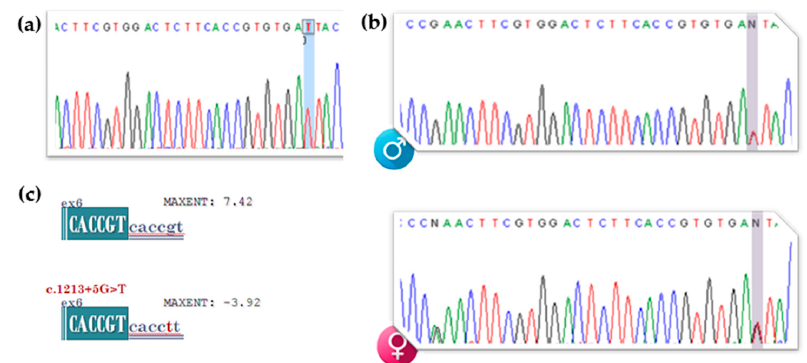
Figure 1. Molecular diagnosis of the patient by classical gDNA screening of the ARSB gene: detection of the novel c.1213+5G>T (IVS6+5G>T) mutation. Electropherogram highlighting the affected residue ( a ) in the patient and ( b ) parents. ( c ) In silico predictions on the effect of the novel mutation over the splice-site junctions. Score predictions by the MaxEntScan bioinformatic tool.